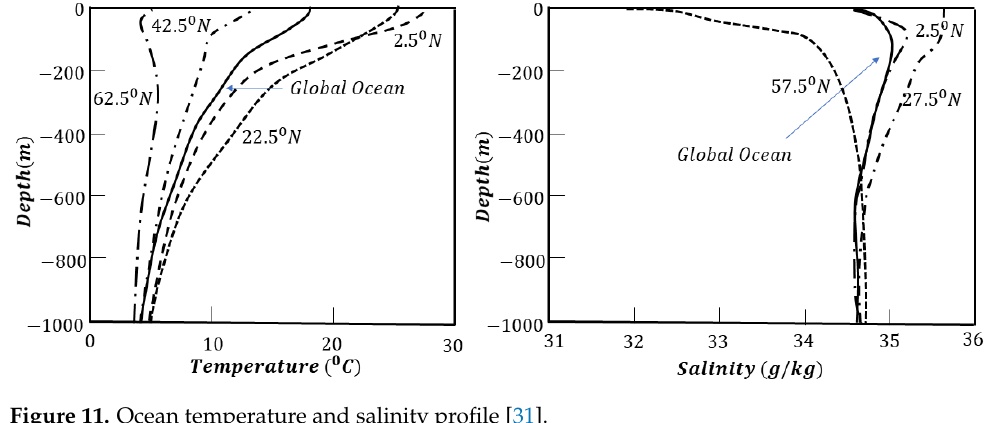
Figure 11. Ocean temperature and salinity profile [31].